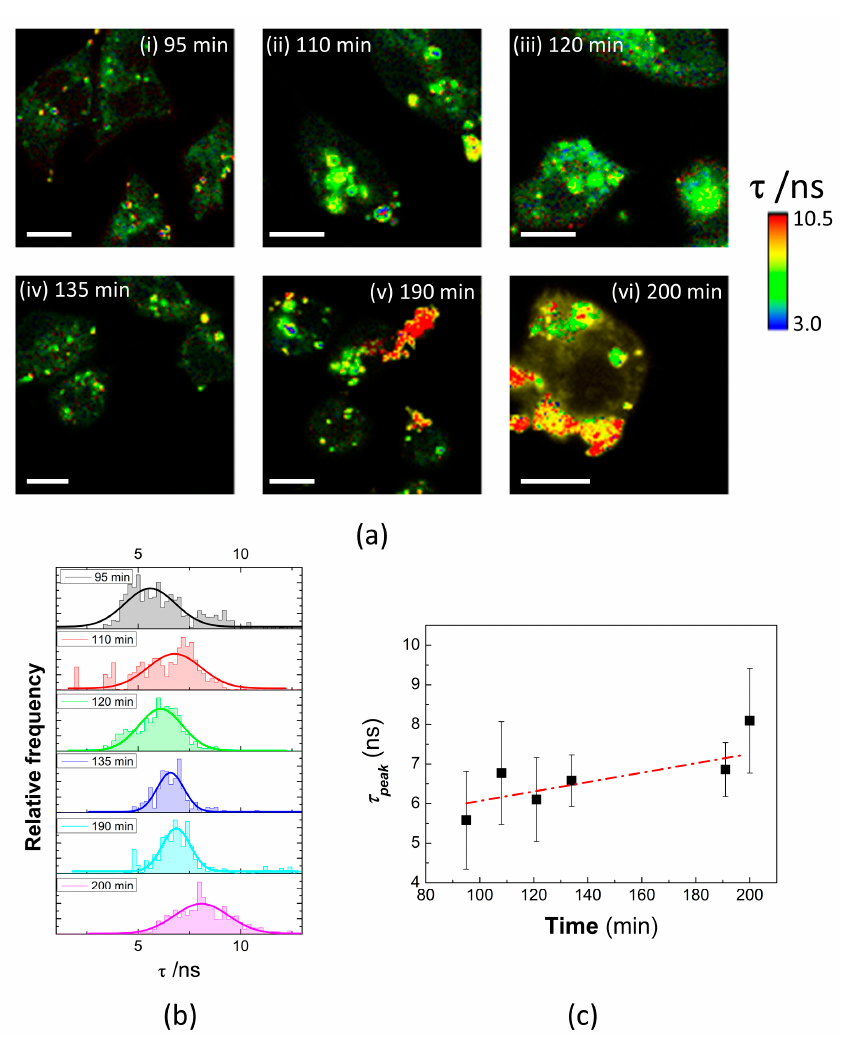
Figure 7. ( a ) FLIM images of QD-APBA conjugates into MDA-MB-231 cells in PBS pH 8.0 before and after addition of a solution of 50 mM glucose to the extracellular medium: (i) 95 min, (ii) 110 min, (iii) 120 min, (iv) 135 min, (v) 190 min, and (vi) 200 min. ( b ) PL Lifetime distributions and ( c ) average PL lifetime calculated from the pixels of interest of the FLIM images in ( a ).